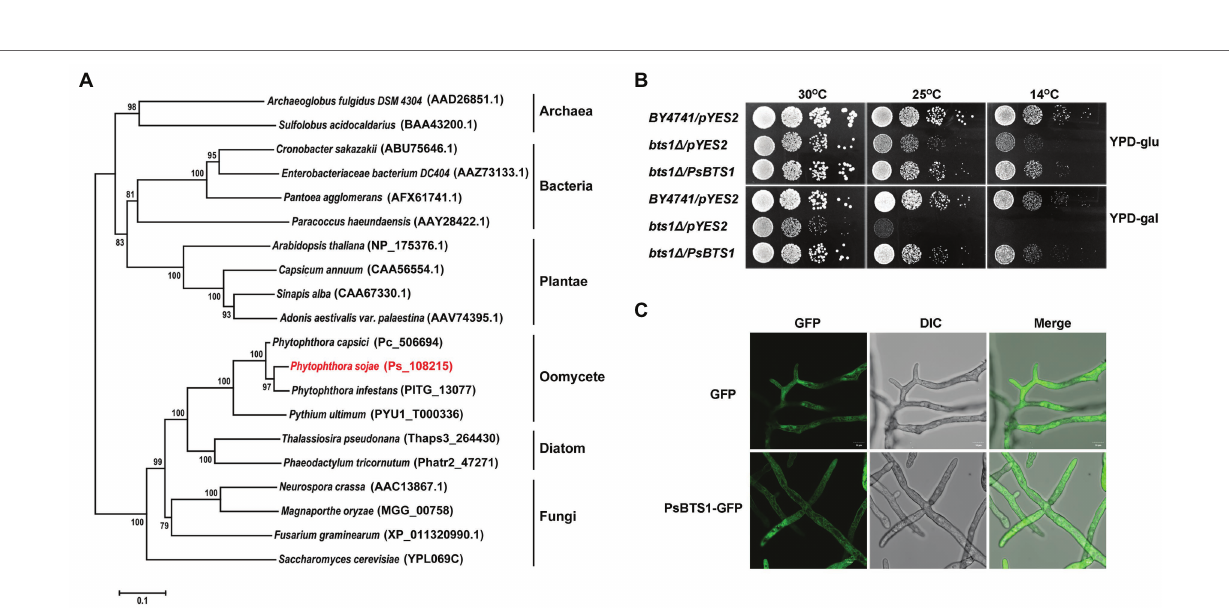
FIGURE 4 | Phylogenetic analysis, enzymatic activity, and subcellular localization of PsBTS1. (A) Phylogenetic analysis of GGPSs from different organisms. GGPS proteins from archaea, bacteria, plants, fungi, diatoms, and oomycetes were analyzed using MEGA6; their sequence IDs in the NCBI GenBank or genome databases are included. (B) PsBTS1 complements the Saccharomyces cerevisiae bts1 Δ mutant growth defect at 14 and 25 ° C. Growth of S. cerevisiae strains BY4741/pYES2 , bts1 Δ / pYES2 , and bts1 Δ / PsBTS1 was tested on YPD plates with glucose (top panel) and galactose (bottom panel) at 14, 25, and 30 ° C. (C) Subcellular localization of PsBTS1. GFP and PsBTS1-GFP fusion protein were expressed in P. sojae and mycelial were analyzed by fluorescence (GFP, 488/515 nm) and bright field (DIC) microscopy. Bar: 10 μ